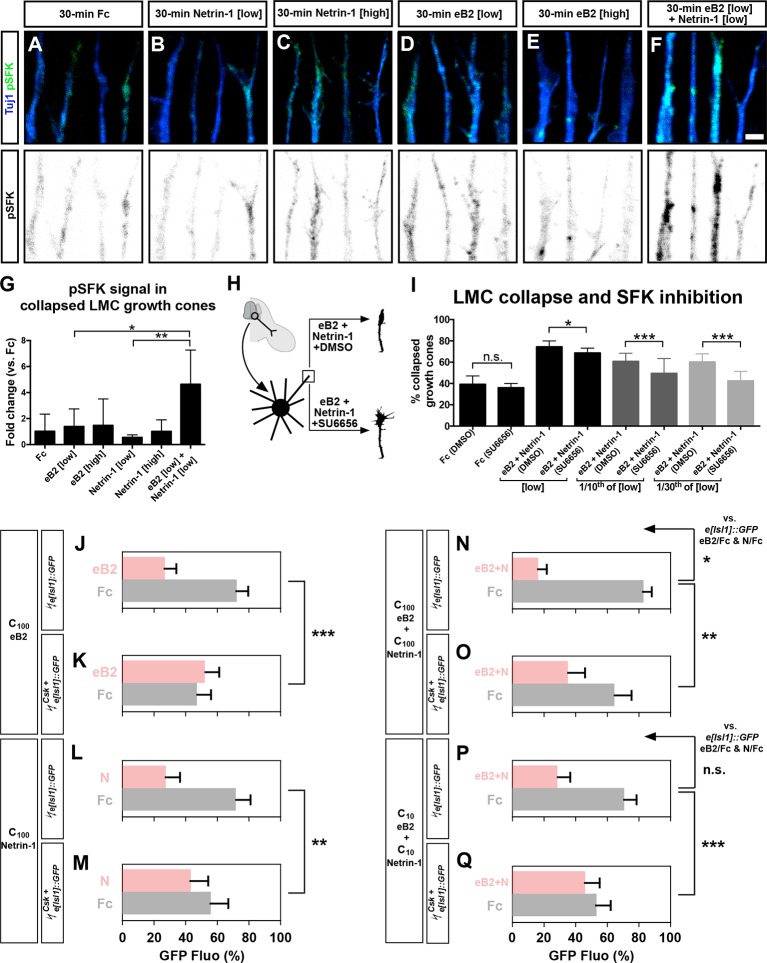
Src family kinases (SFKs) are required for synergistic repulsion from ephrin-B2 and Netrin-1.(A–F) Detection of pSFKs (green) and Tuj1 (blue) in collapsed growth cones after 30’ treatment with Fc (10 μg/ml), low Netrin-1 (0.3 μg/ml), high Netrin-1 (1 μg/ml), low eB2 (1 μg/ml), high eB2 (10 μg/ml), or low eB2 and low Netrin-1 (1 μg/ml and 0.3 μg/ml). Bottom panels show inverted images of the pSFK channel. (G) Quantification of pSFK detected in collapsed growth cones treated as above. In the presence of low Netrin-1 and eB2 concentrations, pSFK signal is increased when compared with low eB2 or low Netrin-1 alone. Statistical significance computed using one-way ANOVA and Tukey's multiple comparisons test; N = 3, n ≥ 10 growth cones per condition per experiment. (H) LMC neuron explant growth cone collapse assay and SFK inhibition scheme. (I) Percentage of collapsed LMC growth cones following 30 min exposure to Fc (10 μg/ml), or Netrin-1 and eB2-Fc (0.3 μg/ml and 1 μg/ml; 1/10th of this concentration; or 1/30th of this concentration), in the presence or absence of 0.1 μM SFK inhibitor SU6656. N ≥ 3, significance computed using Fisher’s exact test with n > 400 growth cones for each treatment. (J–Q) Quantification of medial (GFP+) LMC neurites of e[Isl1]::GFP-electroporated explants on C100 eB2/Fc (J), C100 N/Fc (L), C100 eB2+N/Fc (N), and C10 eB2+N/Fc (P), and Csk and e[Isl1]::GFP-co-electroporated explants on C100 eB2/Fc (K), C100 N/Fc (M), C100 eB2+N/Fc (O), and C10 eB2+N/Fc (Q). Quantification of neurites on first (pink) and second (gray) stripes expressed as a percentage of total GFP signals. Minimal number of neurites: 80. Minimal number of explants: 12. Statistical significance computed using Mann-Whitney U test. eB2, ephrin-B2-Fc; LMC, lateral motor column; N, Netrin-1; All error bars = SD; n.s.: not significant; *: p<0.05; **: p<0.01; ***: p<0.001; scale bar: 2 μm. All values (mean ± SD) can be found in Supplementary file 1B.